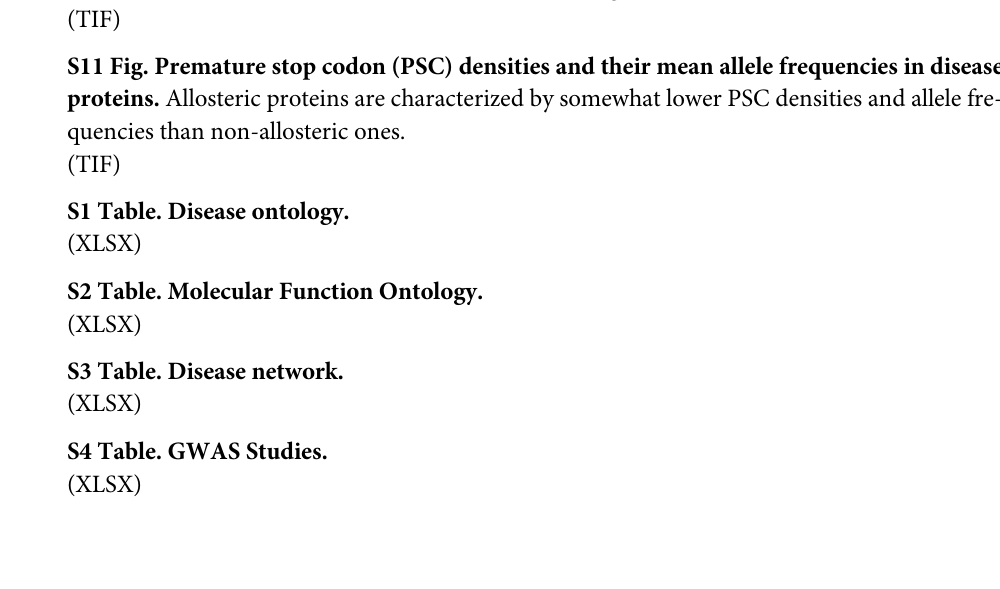
S1 Table. Disease ontology. S2 Table. Molecular Function Ontology. S3 Table. Disease network. S4 Table. GWAS